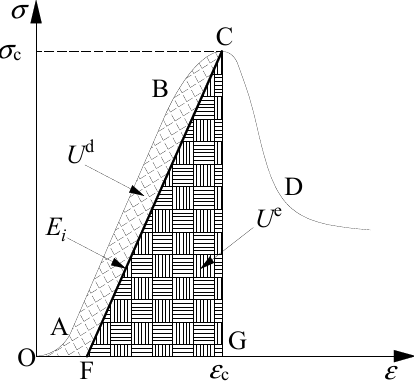
Figure 9. Principle of rock energy calculation.